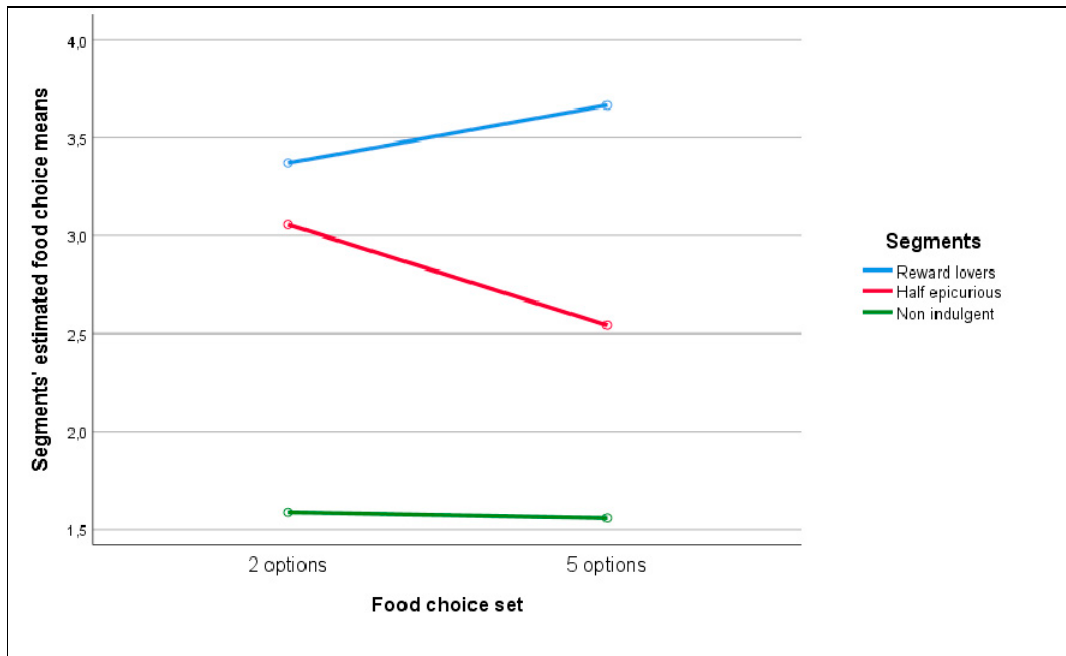
Figure 6. Mean food choice selection as a function of segment and food-choice set.